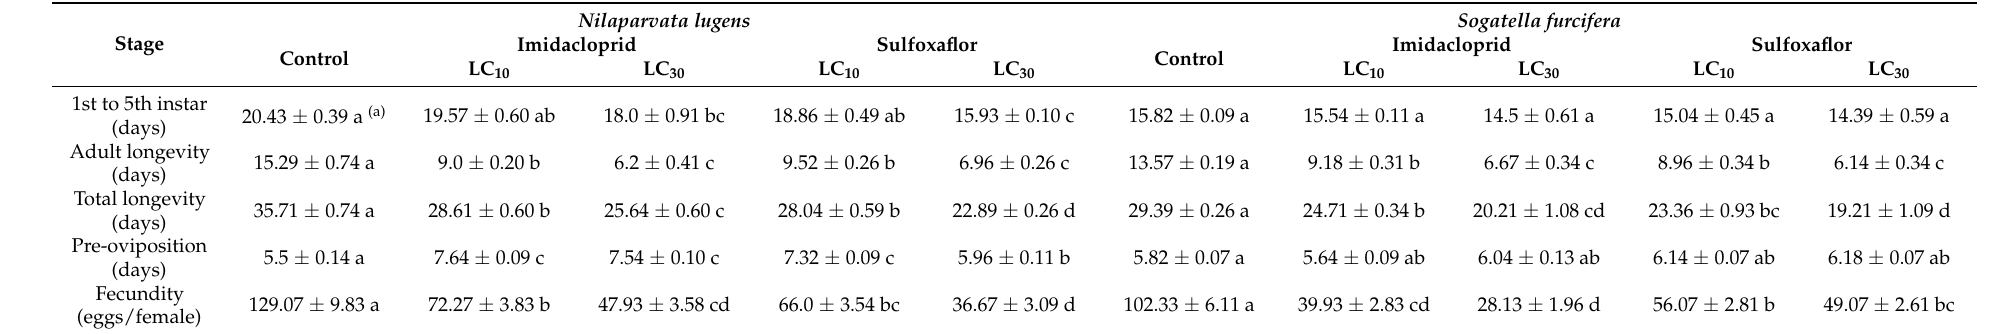
Table 4. Developmental duration, longevity, and fecundity of Nilaparvata lugens and Sogatella furcifera on